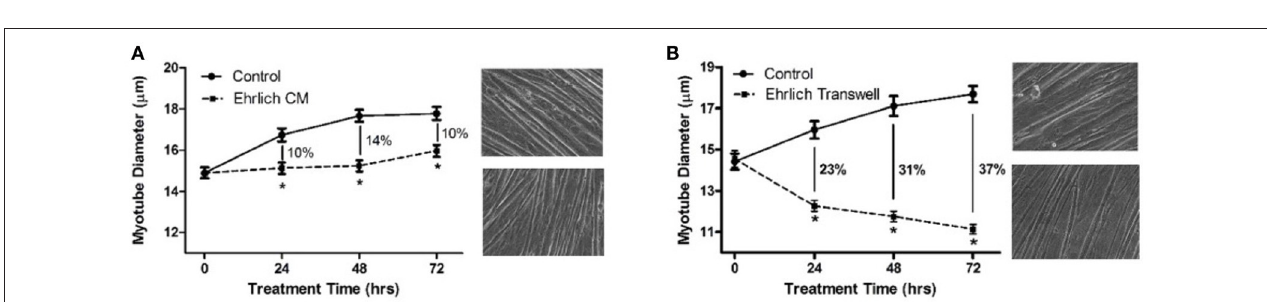
FIGURE 3 | Myotube diameters in response to treatment with Ehrlich tumor cell CM or Ehrlich-Transwell inserts. (A) Treated with DM (control) or Ehrlich CM for 72 h. DM or Ehrlich CM was refreshed every 24 h, and photographs of the wells were taken just before feeding. Percent atrophy indicated for each treatment time point in graph. (B) Treated with DM or Transwell inserts containing Ehrlich tumor cells, medium refreshed every 24 h, again, photographs of the bottom wells taken just before feeding. To the right of each graph are photographs of phase images of representative wells of control (top) and treated (bottom) myotubes at 72 h. * P < 0.05 compared to control